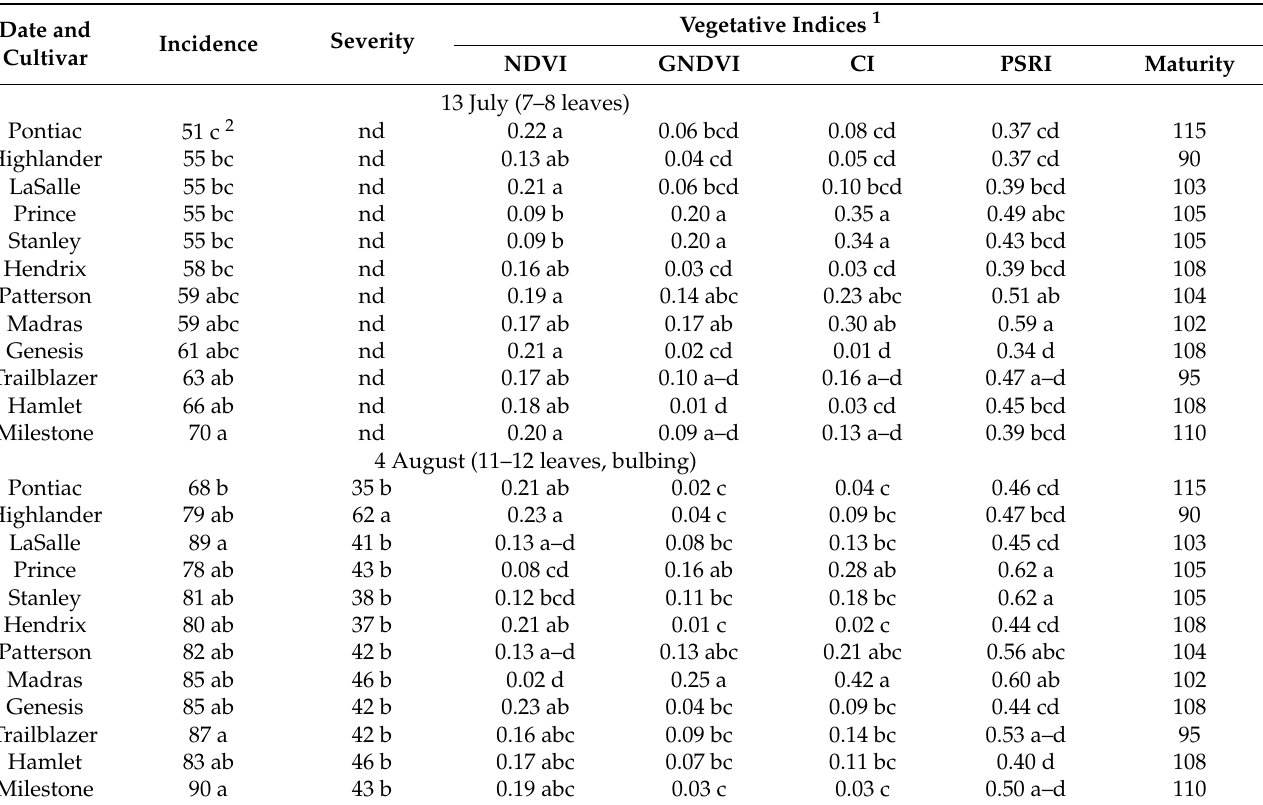
Table 2. Stemphylium leaf blight incidence, severity (leaf dieback) in July and August and four vegetative indices were calculated for an onion cultivar trial at the Muck Crops Research Station, Holland Marsh, ON in 2015.